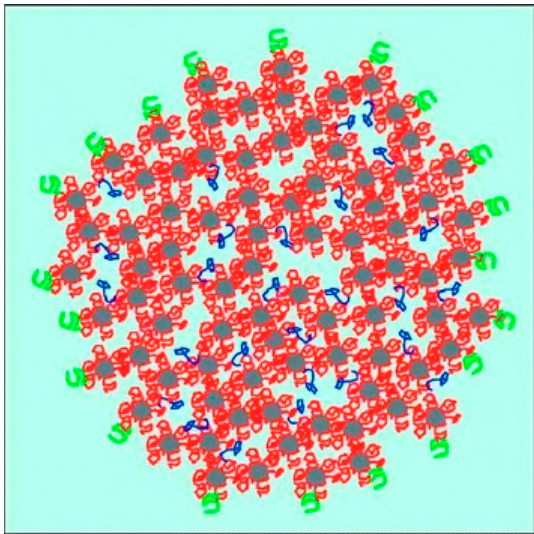
Figure 1. Schematic illustration of the casein micelle structure, incorporated calcium phosphate nanoclusters (grey) with their attached caseins (red), the surface-located κ -casein (green), and hydrophobically bound mobile β -casein (blue). Individual components are not to scale. Reproduced with permission from [3], copyright by The Royal Society of Chemistry, 2011.